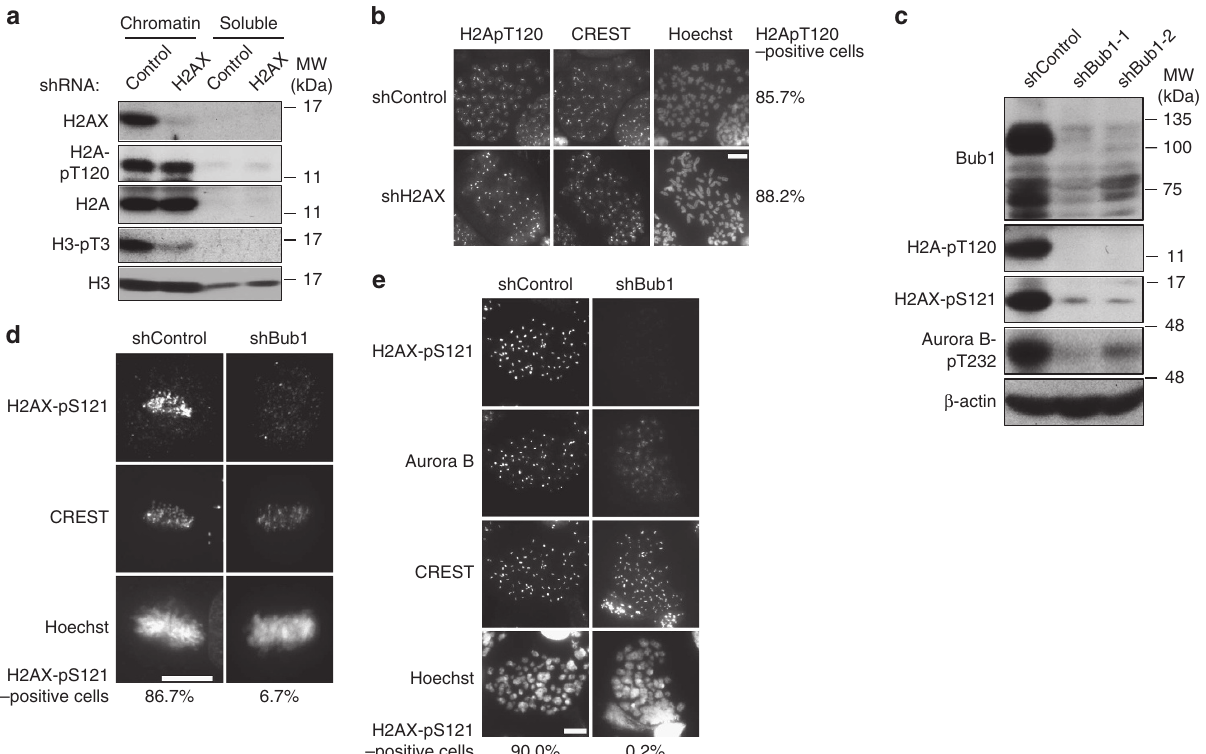
Figure 5 | H2AX-pS121 functions downstream of Bub1-H2A-pT120. ( a ) HeLa cells expressing the Dox-inducible shControl or shH2AX were treated as in Fig. 2d. Chromatin fractions from mitotic cells were subjected to immunoblotting with the indicated antibodies. ( b ) Metaphase spreads from HeLa cells expressing shControl or shH2AX in the presence of doxycycline (1 m gml (cid:2) 1 ) were fixed and stained with antibodies against H2A-pT120, CREST and Hoechst. Representative images and the percentage of the H2A-pT120-positive cells are shown ( n Z 65). Scale bars, 10 m m. ( c ) HeLa cells expressing the Dox-inducible shControl, shBub1-1 or shBub1-2 were treated as in Fig. 2d. Chromatin fractions from mitotic cells were subjected to immunoblotting with the indicated antibodies. ( d , e ) HeLa cells expressing shControl or shBub1-1 were fixed for immunofluorescence ( d ) ( n Z 25) as in Fig. 2c or for mitotic spread ( e ) ( n Z 20) as in ( b ). Representative images and the percentage of the H2AX-pS121-positive cells are shown. Scale bars, 10 m